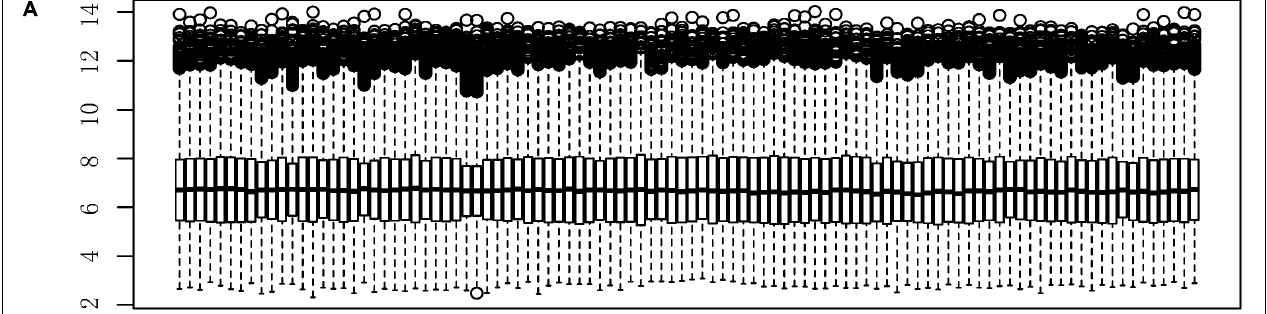
in the red module showed decreasing expression levels with greater disease severity, and markedly decreased expression levels in different BPD severity conditions ( Figure 5B ). To